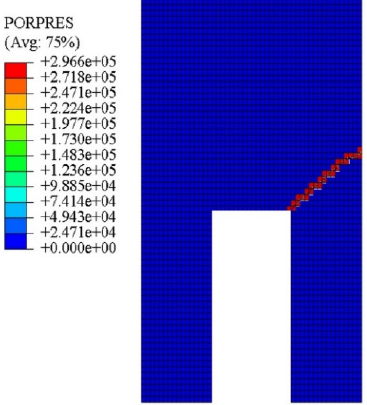
Figure 8. Pressure cloud diagram of fracture surface (unit: Pa).